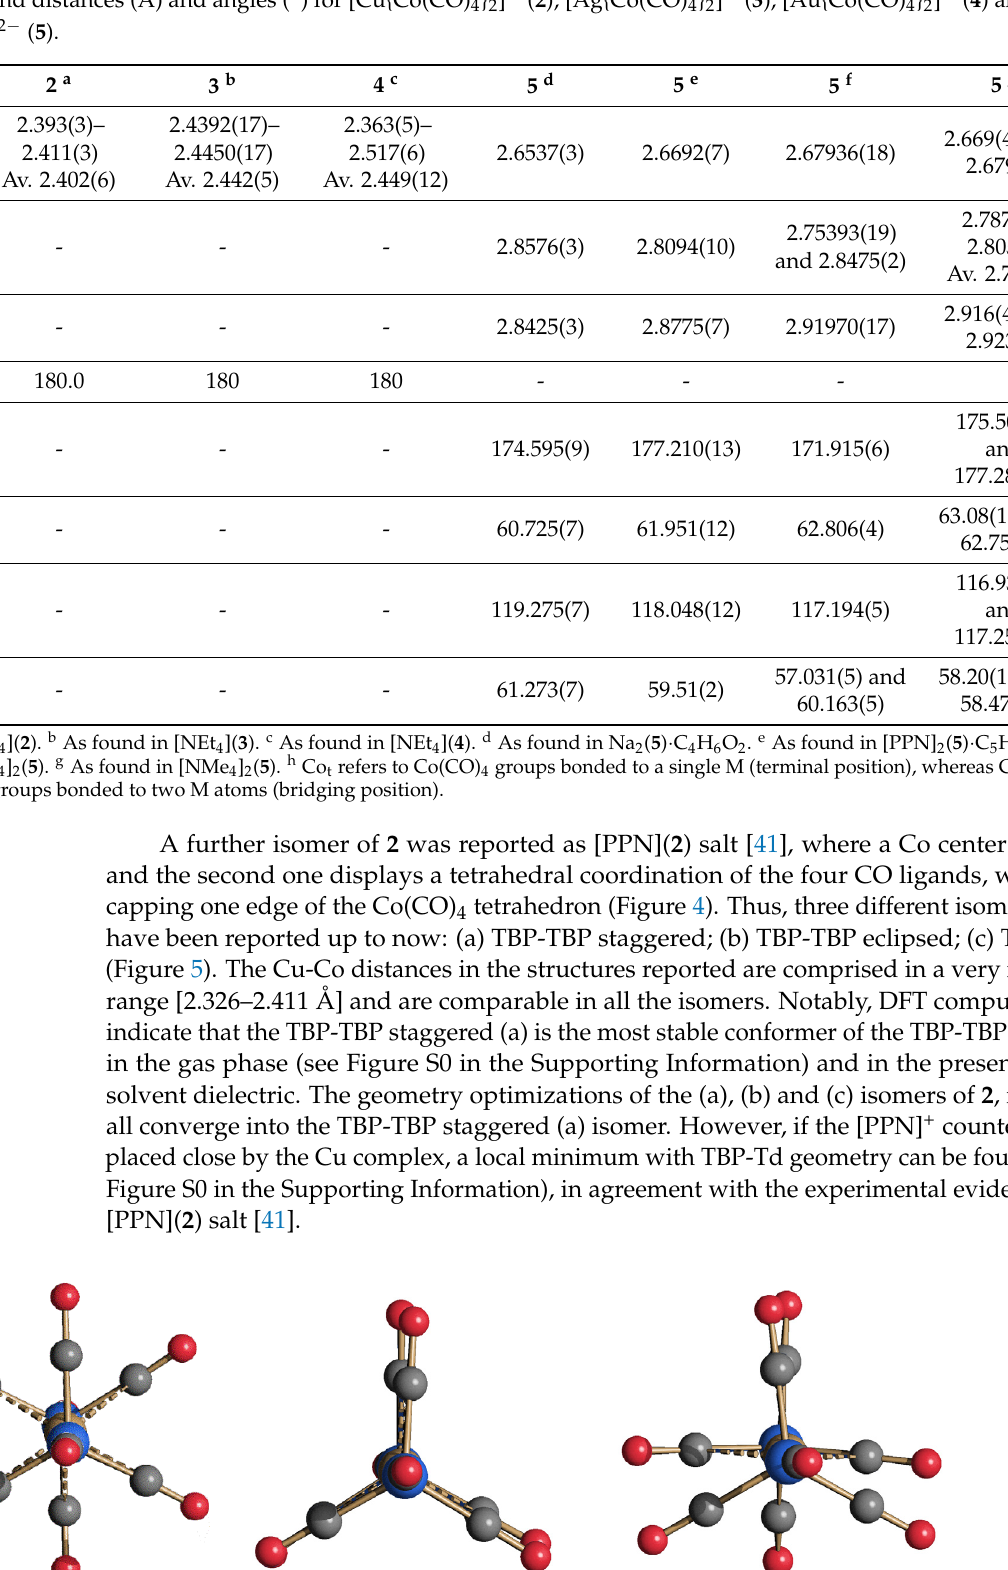
Table 1. Main bond distances (Å) and angles ( ◦ ) for [Cu{Co(CO) 4 } 2 ] − ( 2 ), [Ag{Co(CO) 4 } 2 ] − ( 3 ), [Au{Co(CO) 4 } 2 ] − ( 4 ) and